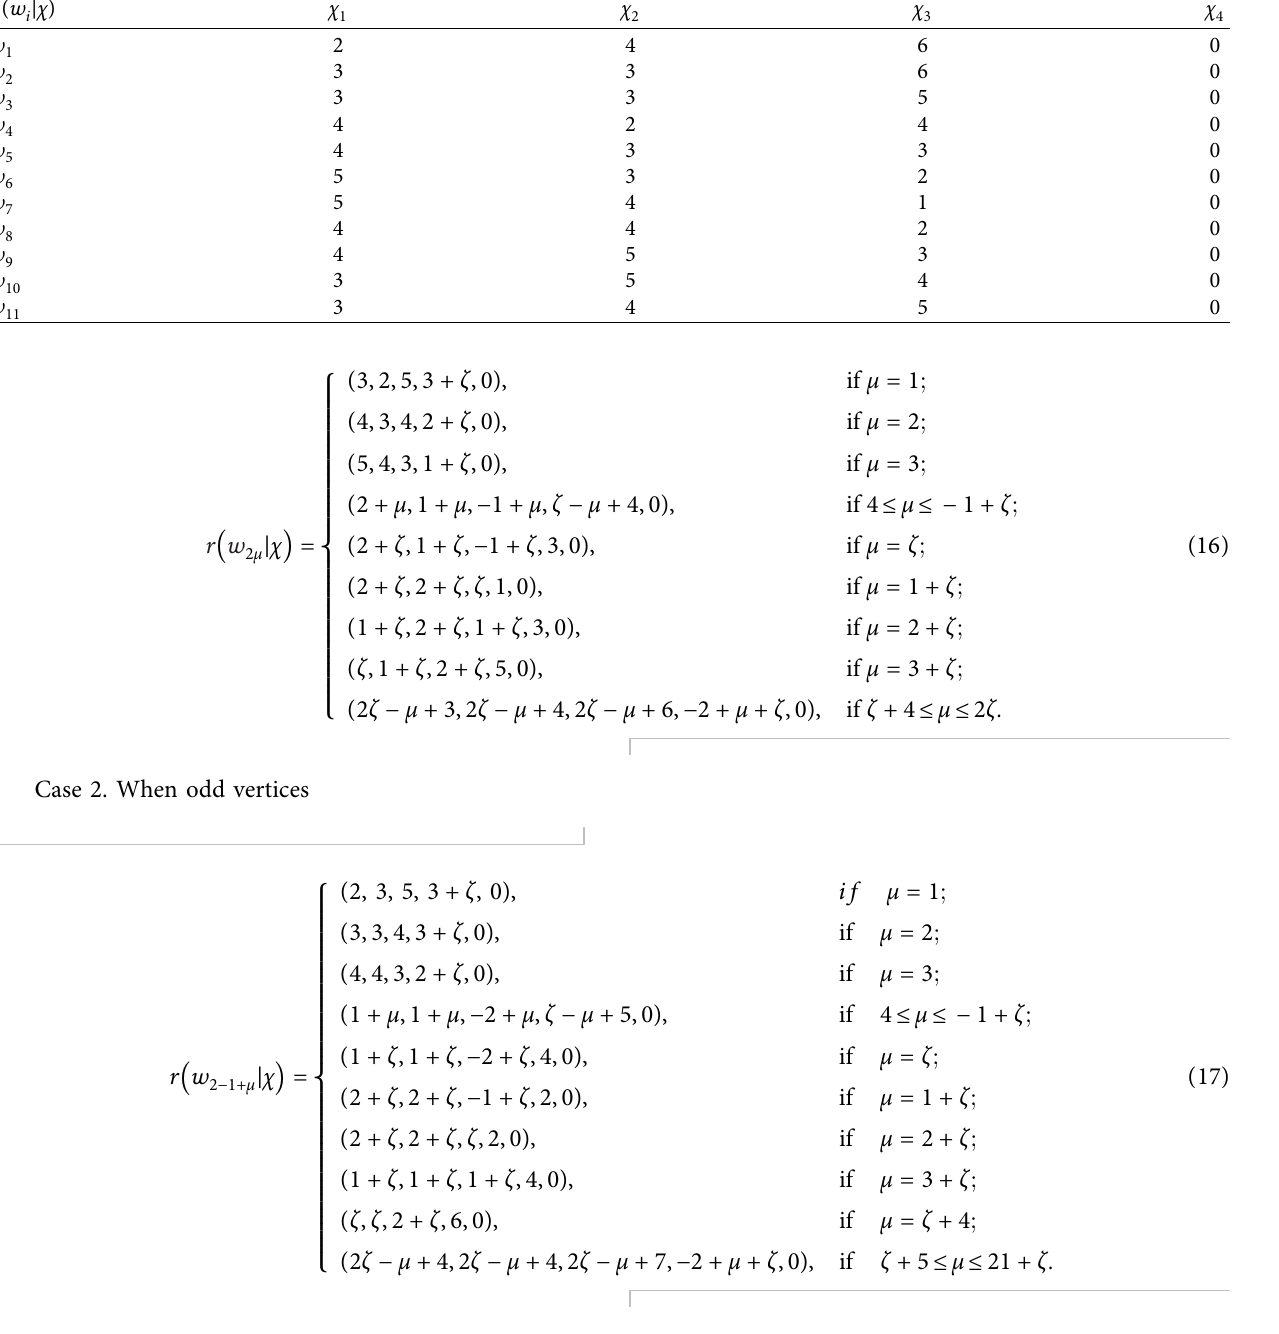
Table 3: Representations of the vertices when n � 13 with regards to χ